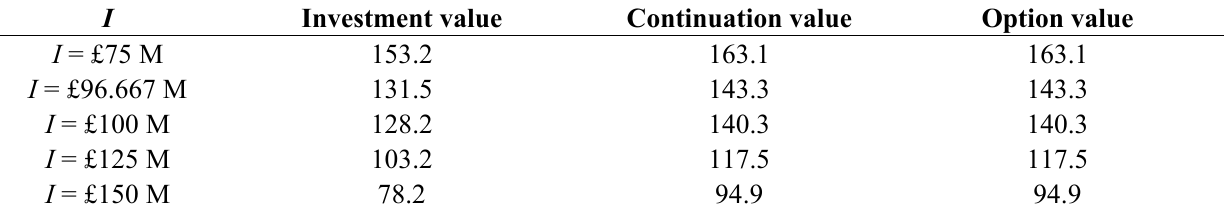
Table 17. Option value (£M) under electricity price plus ROC